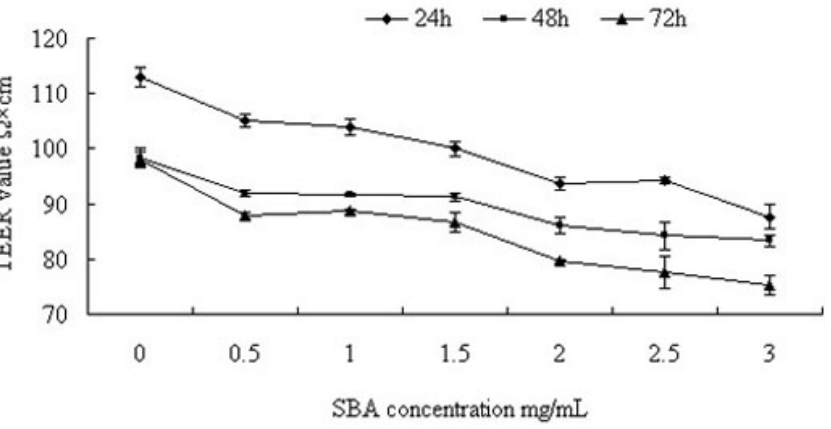
Figure 1. Effects of SBA on TEER in IPEC-J2 cells. Cells were treated with various concentration of SBA for 24 h, 48 h, or 72 h, TEER values are expressed in Ω × cm 2 as the mean ± standard error from 3 independent experiments and presented a significant decline in a time and dose-dependent ( p < 0.05). The control group was treated with 0 mg/mL SBA for the indicated times (24, 48, or 72 h). Treatment of 0.5, 1.0 or 1.5 mg/mL SBA group had a significant decrease compared with control ( p < 0.05), in addition, 2.0, 2.5 or 3.0mg/mL had a significant decrease compared with 0.5,1.0 or 1.5 mg/mL SBA treatment groups ( p < 0.05) (48 h or 72 h). However no significant differences were observed among 0.5, 1.0 and 1.5 mg/mL treatment, or between the 2.0 and 2.5 mg/mL SBA treatment ( p >